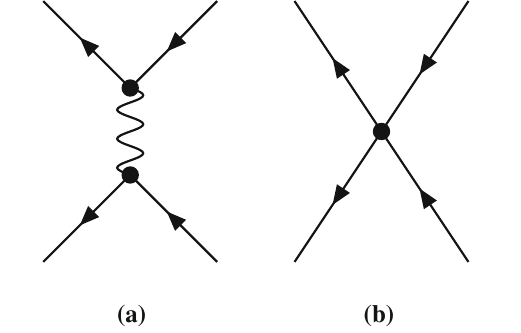
Fig. 2 Contributions to the fermion-fermion scattering for the dual model